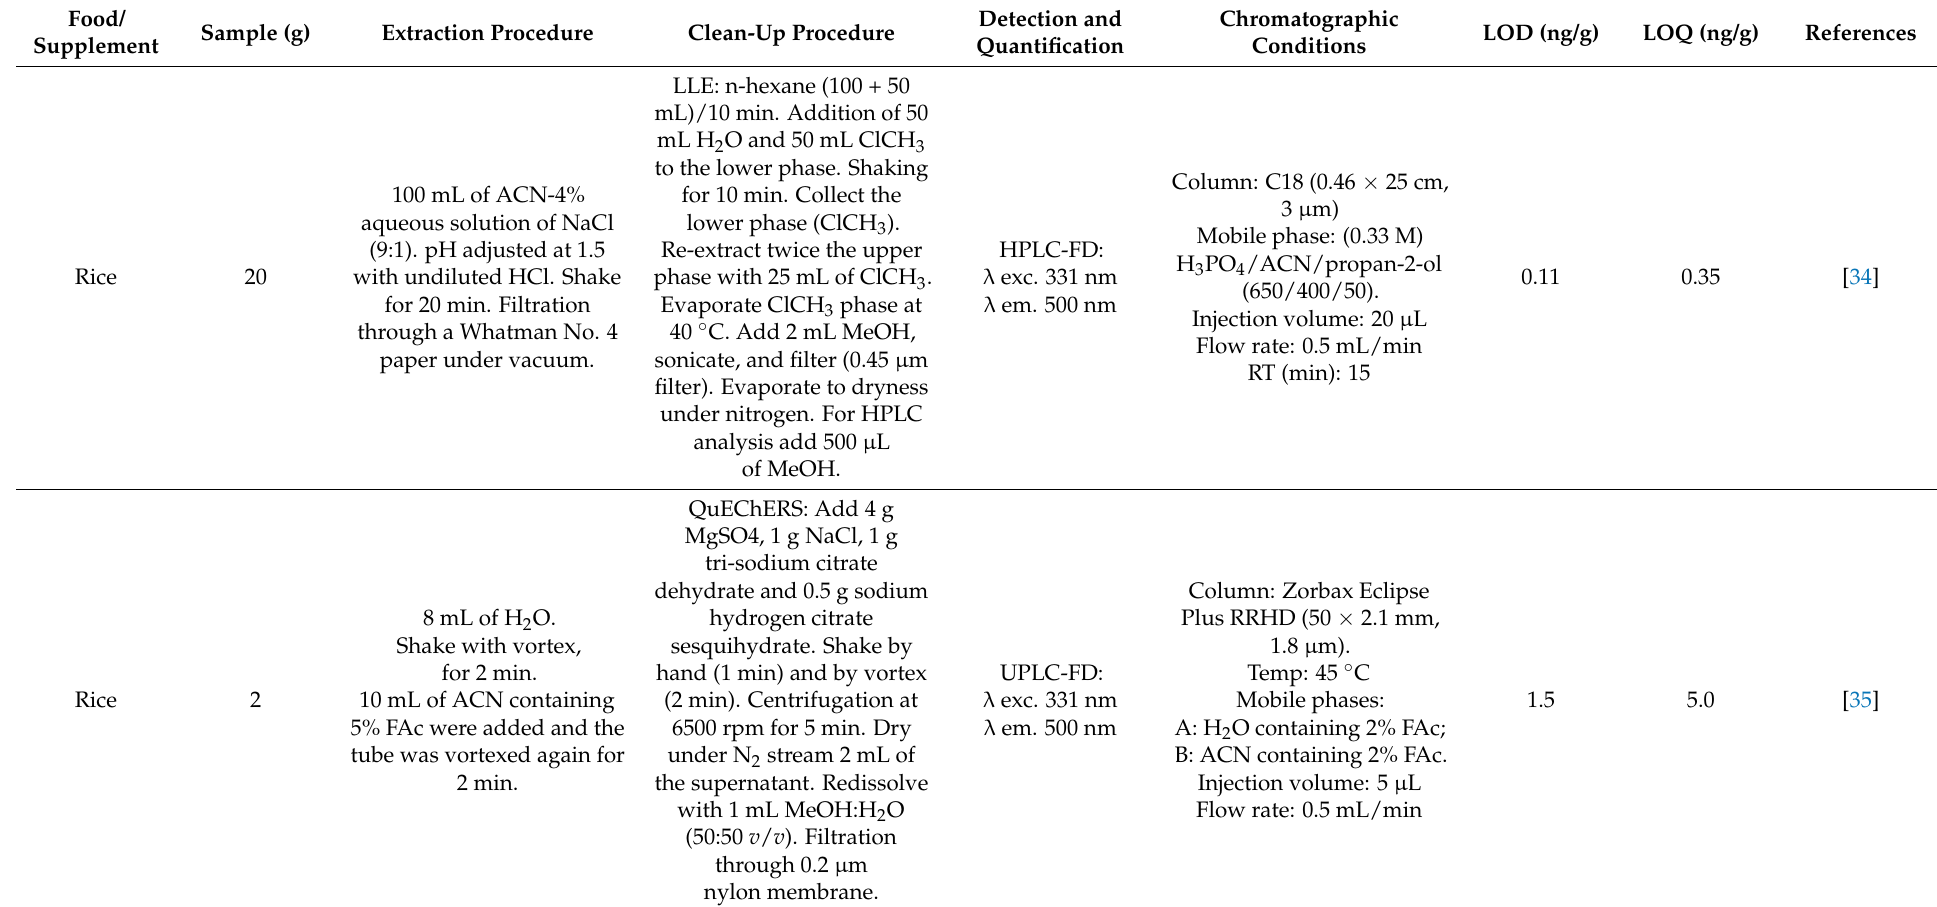
Table 2. Analytical methodologies for determination of CIT in foods and